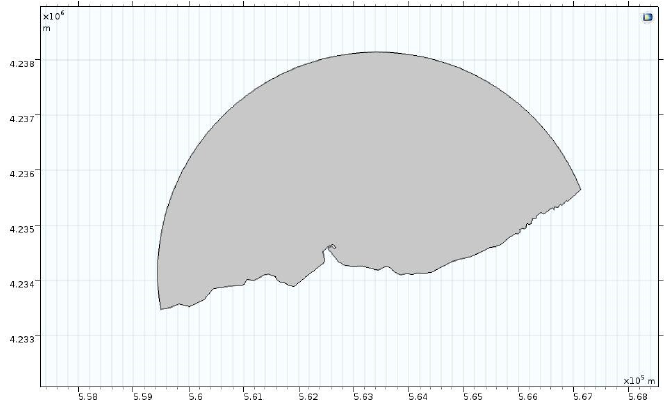
Figure 17. Scilla computational domain purified from the part of the land (source COMSOL).